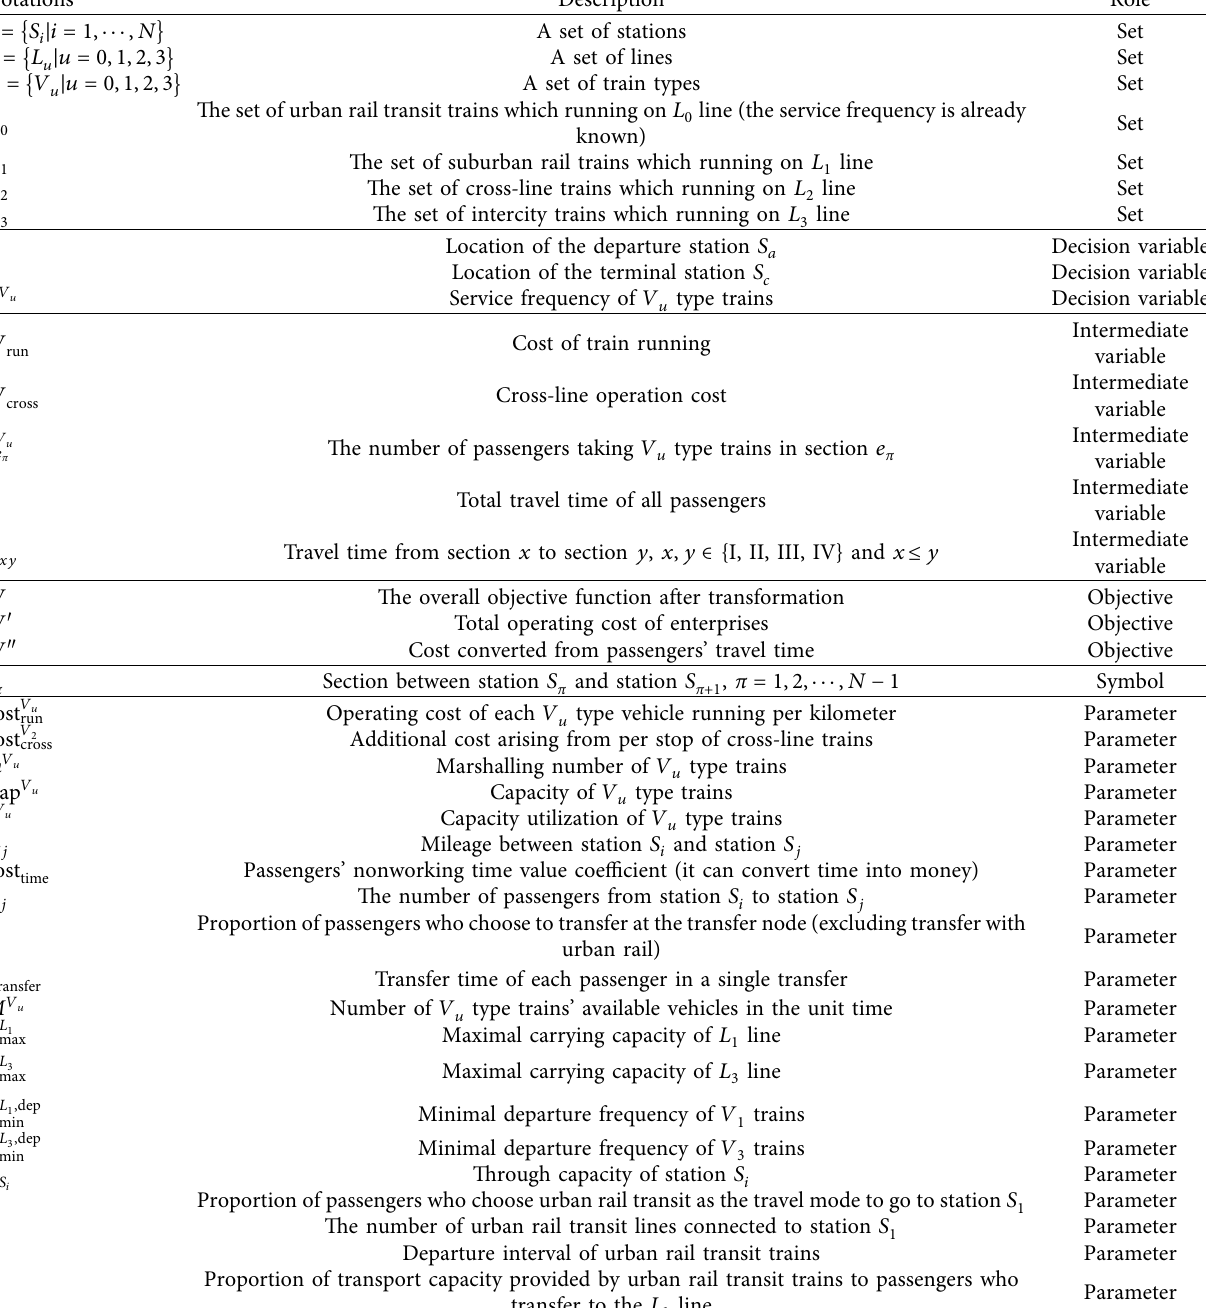
Table 2: The notations used in the